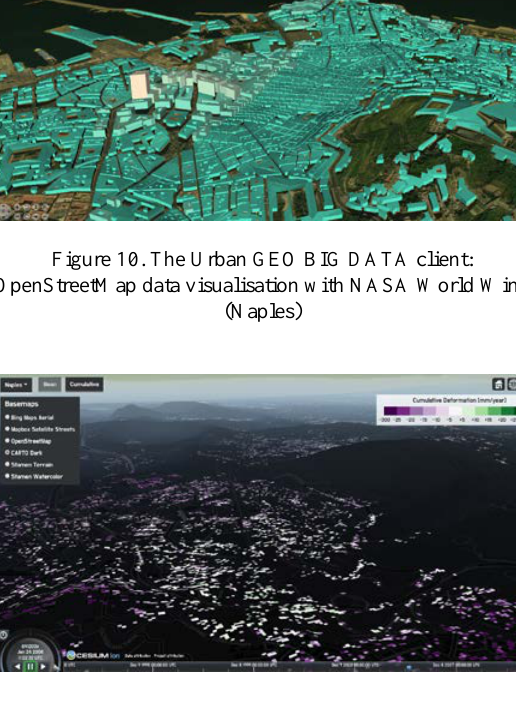
Figure 11. The Urban GEO BIG DATA client: ground displacements with Cesium JS